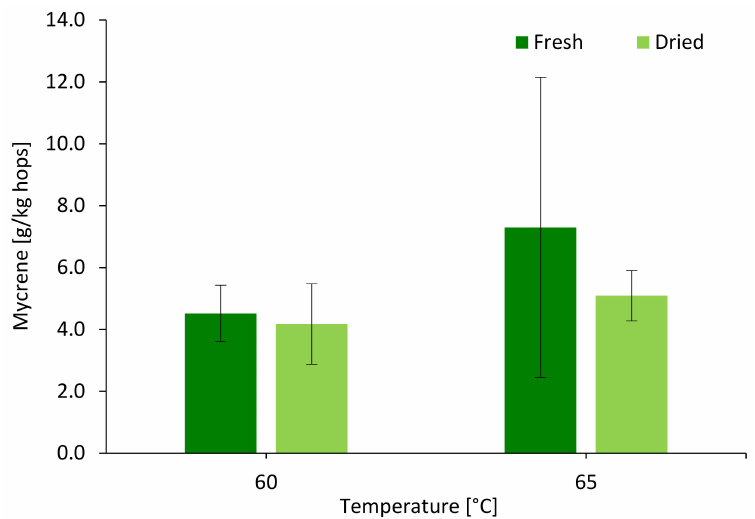
Figure 9. Results obtained from gas chromatography analysis for myrcene in g / kg hops at 0 min and 210 min for hop cones dried at 60 ◦ C and 65 ◦ C at 0.35 m /